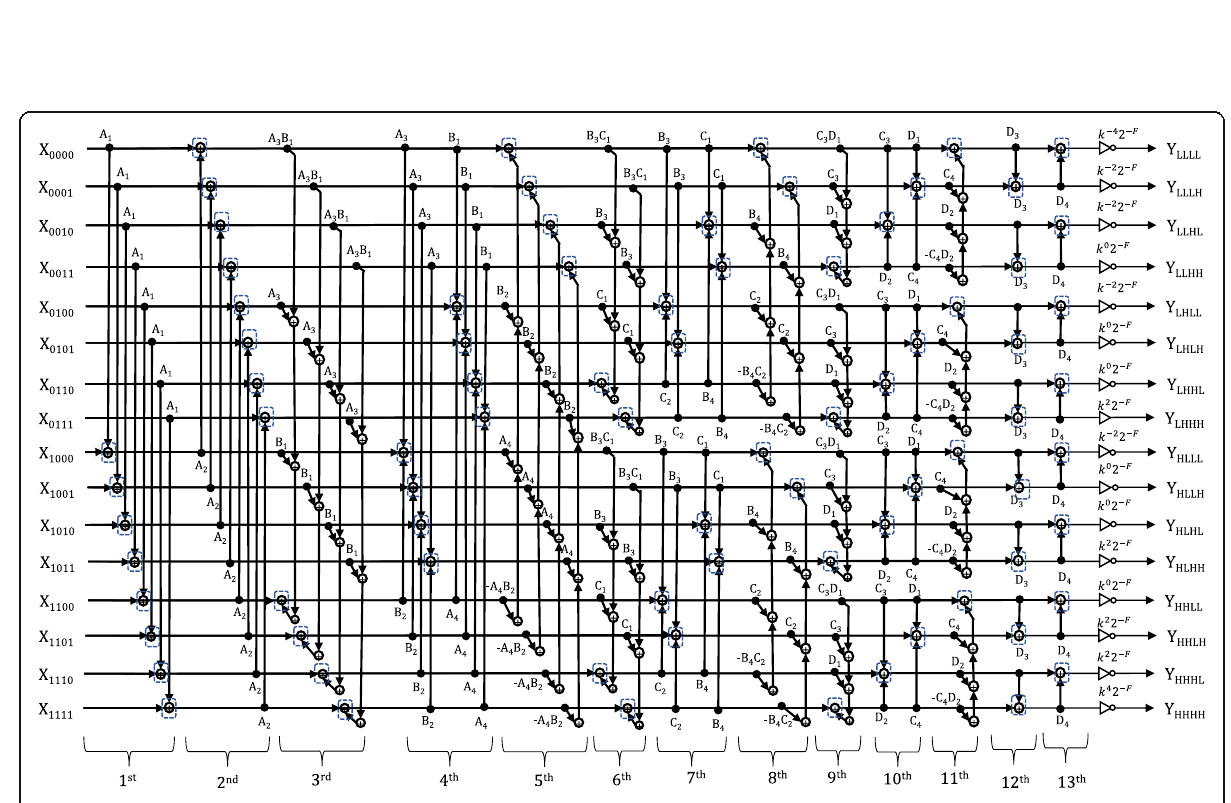
Fig. 7 Non-separable 2D structure for 9/7-type of transform (proposed II)